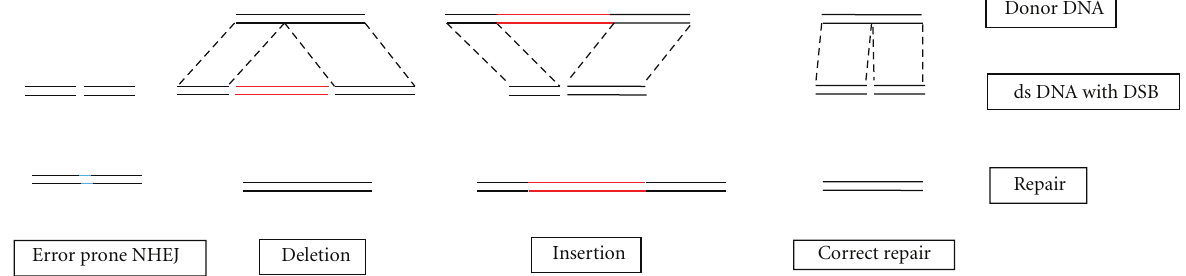
Figure 2: Possibilities of genetic repair using zinc finger nucleases, ds: double-strand, DSB: double-strand break, NHEJ: non-homologous end